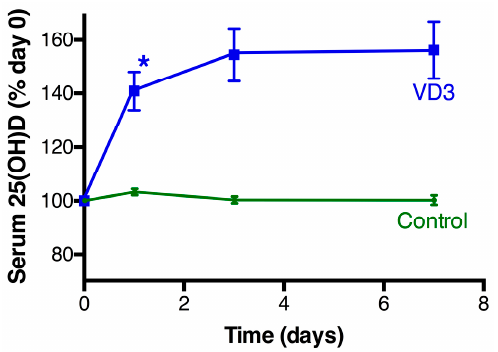
Table 1. Participant